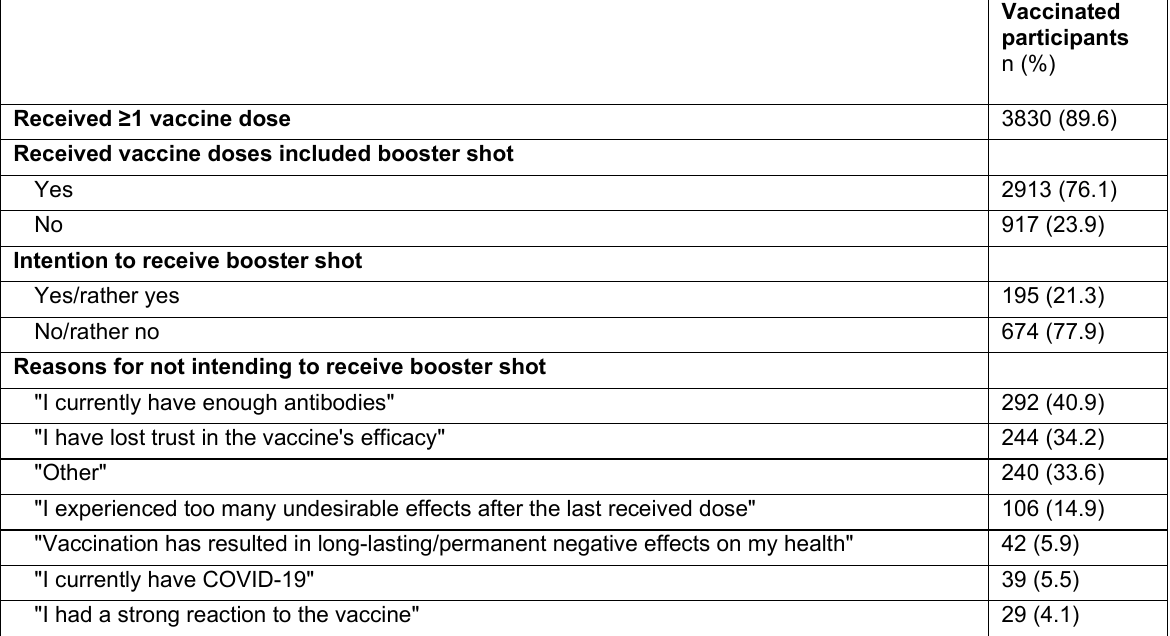
Supplementary table 5 . Vaccination rate and reasons for refusing to receive a booster